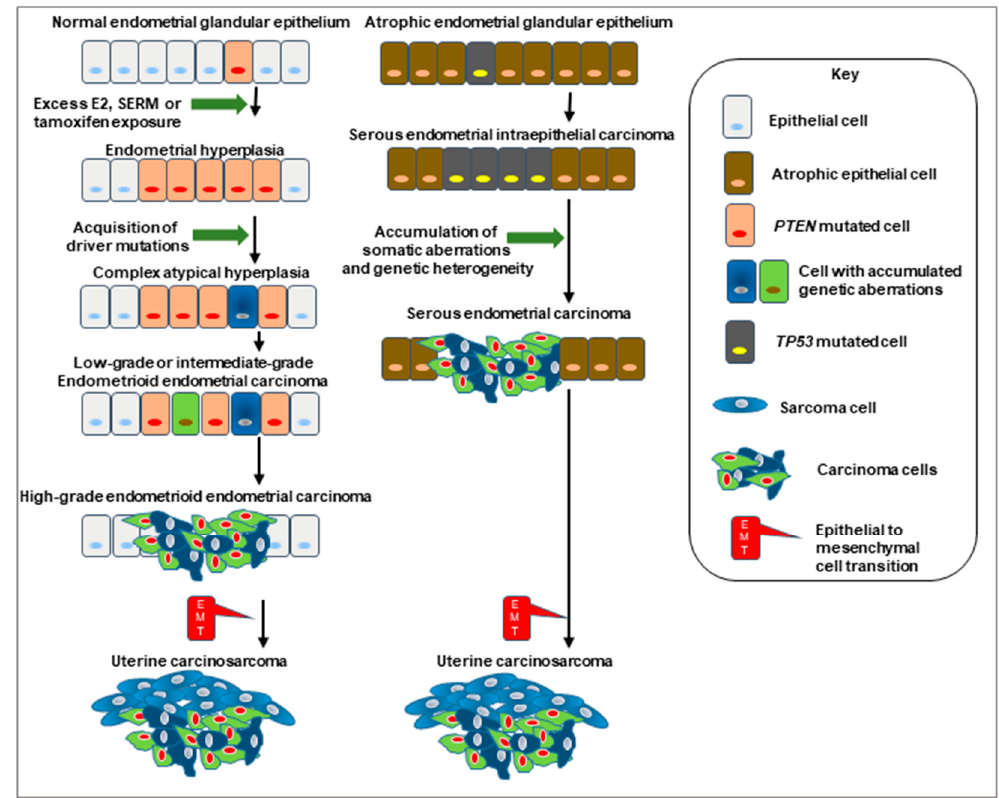
Figure 4. Overview of endometrial cancer origin and development. A schematic representations of the development of and progression of endometrioid (Type 1) EC (left side) and of non-endometrioid serous (Type 2) EC (right side) from their respective normal and atrophic endometrial glandular epithelial cells. During initiation, PTEN or TP53 gene mutations (early events in the aetiopathology of many endometrioid and serous ECs) and other genetic aberrations result in the formation of precursor lesions (complex atypical hyperplasia and serous intratumoural intraepithelial carcinoma, respectively). The epithelial cells that accumulate mutations and genetic alterations are coloured. Sometimes, carcinomas (particularly high-grade tumours) undergo epithelial to mesenchymal cell transition (EMT), giving rise to uterine carcinosarcomas, which as dualistic tumours consist of both epithelial carcinoma cells and sarcoma cells (dark blue and green cells and ovoid blue cells, respectively). Data are adapted from